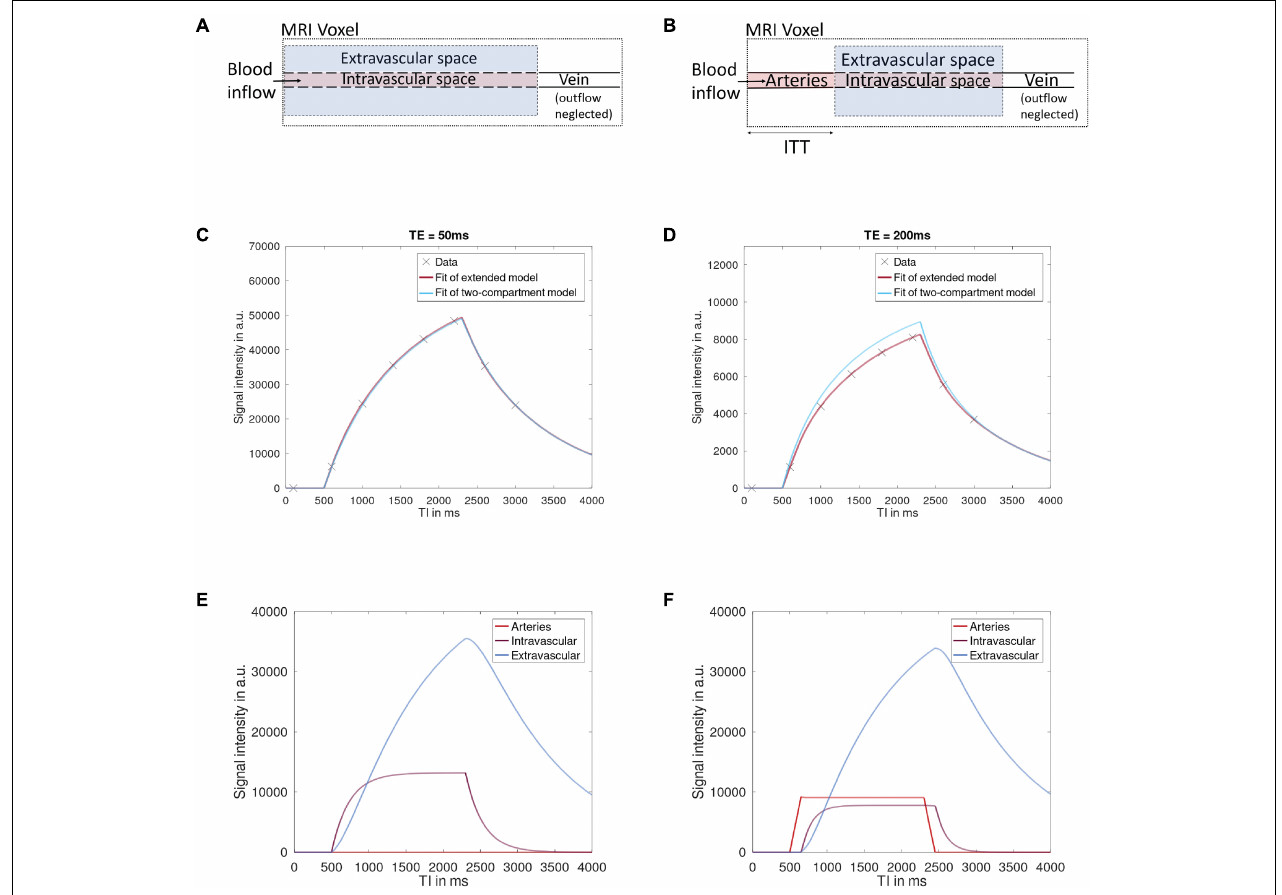
FIGURE 1 | The schematic structure of the MRI voxel is shown as assumed by the two-compartment model (A) and the extended model (B) . In the extended model, it can be seen that the signal from the arteries is also included as an additional component. After arrival in the voxel, the labelled blood flows through the arteries during the ITT to the capillary exchange site where exchange of the labelled blood between the vessel (intravascular space) and tissue (extravascular space) takes place. Signal curves for data simulated at TE = 50 ms (C) and TE = 200 ms (D) are shown. The two models generate nearly identical signal curves at a lower TE, but at a higher TE value, the two-compartment model could not properly reproduce the signal. The composition of the total signal from the individual components resulting from the two-compartment model (E) and the extended model (F) is